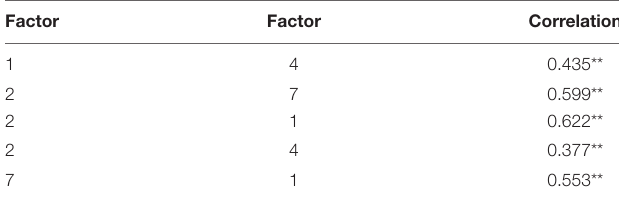
TABLE 13 | Correlations between the